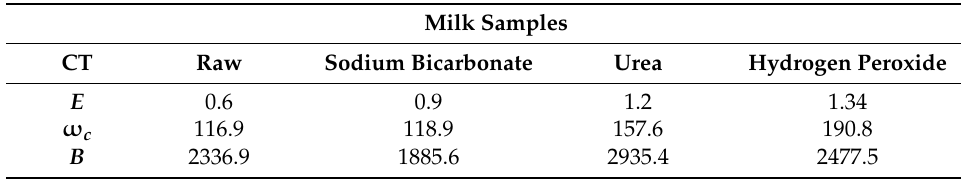
taken as an average of 10 emitting-receiving tests. Table 1. Standard deviation of the tests.